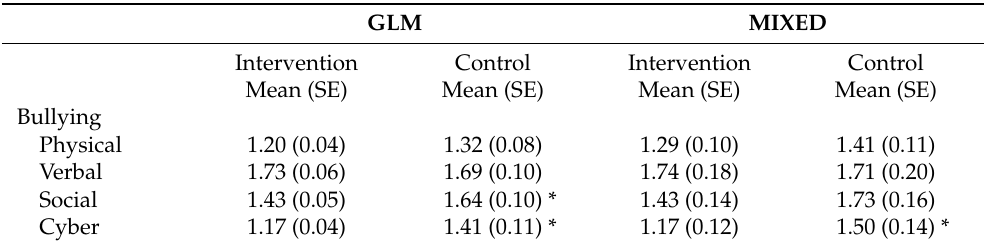
Table 5. Adjusted Means at Post-Test for Bullying Perpetration by Condition, GLM and MIXED